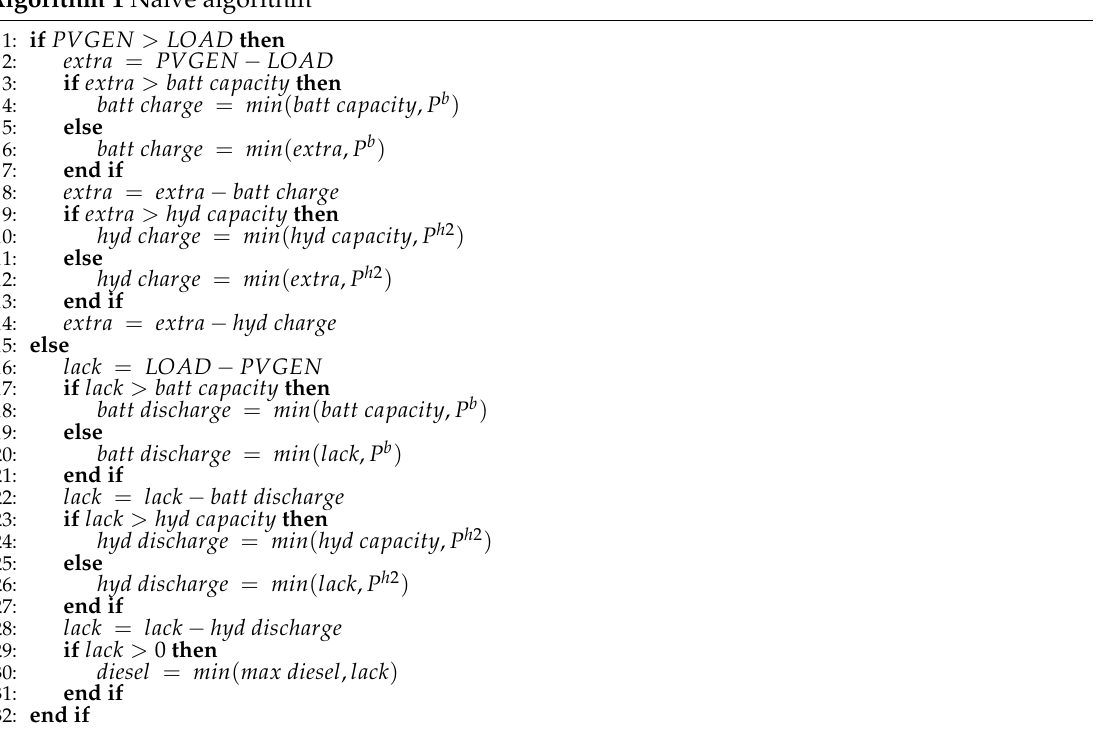
Algorithm 1 Naive